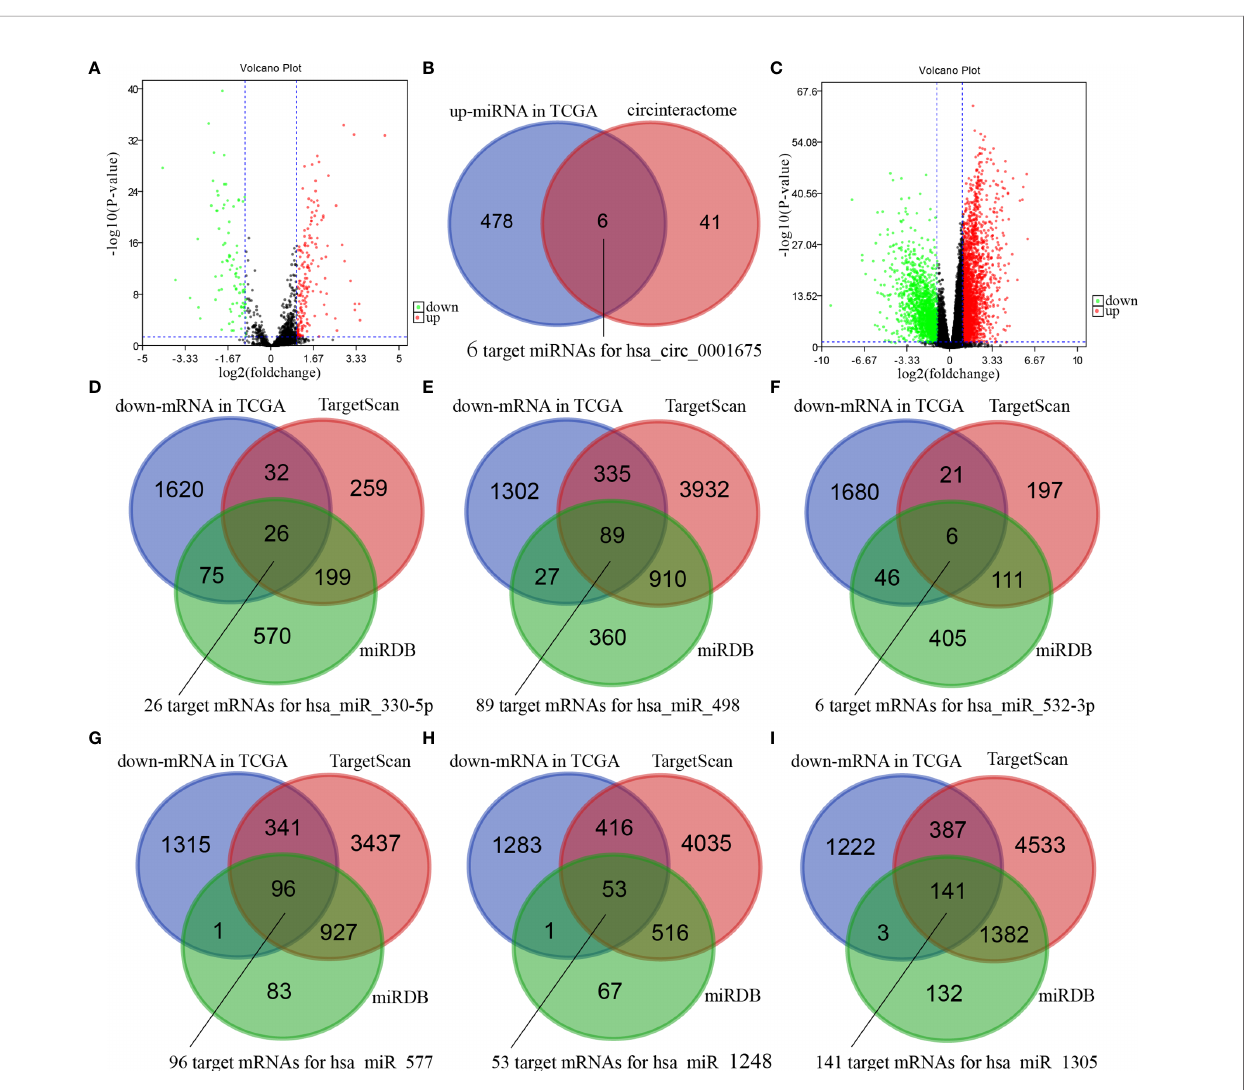
FIGURE 4 | Bioinformatics projections of hsa_circ_0001675. (A) A volcano plot showing differentially expressed miRNAs in TCGA. The red dots indicate up- regulated miRNAs, and the green dots indicate downregulated miRNAs. The black dots represent miRNAs that were not differentially expressed. (B) Venn diagram of the overlap of up-regulated miRNAs in TCGA and predicted miRNAs in the circular RNA interactome database. (C) A volcano plot showing differentially expressed mRNAs in TCGA. The red dots indicate up-regulated mRNAs, and the green dots indicate down-regulated mRNAs. The black dots were not differentially expressed mRNAs. (D – I) Venn diagrams of the overlap of predicted mRNAs by TargetScan and miRDB databases and down-regulated mRNAs in